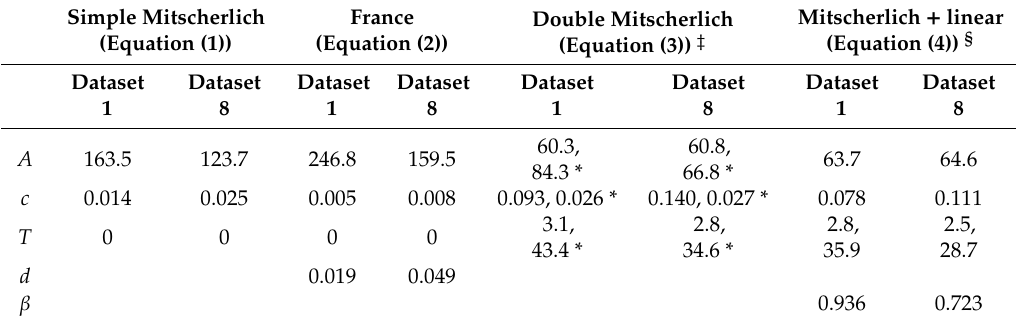
Table 2. Parameter estimates obtained by fitting Equations (1)–(4) to Dataset 1 (laminitis) and 8 (clinically normal) from Experiment 1. An asterisk (*) denotes the equation that resulted in the best fit, based on AIC, to a particular dataset.